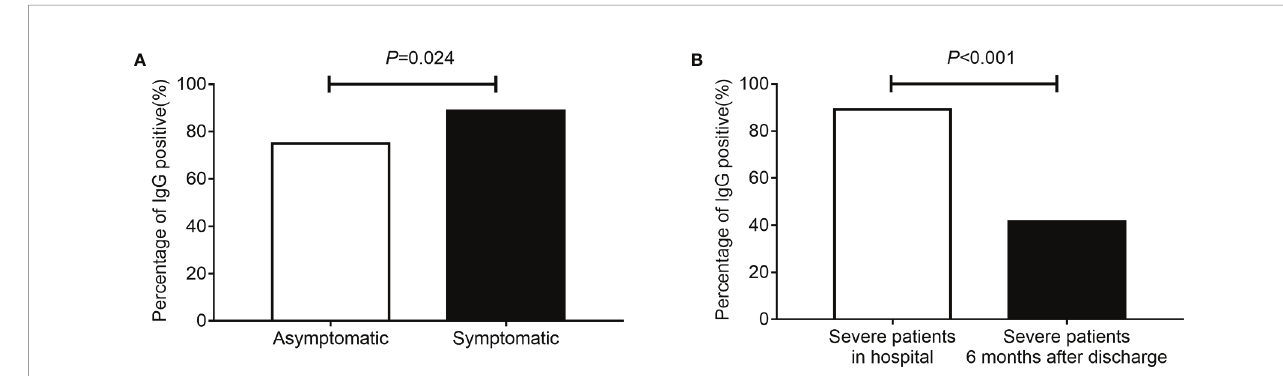
FIGURE 2 | The percentage of IgG positive. The percentage of IgG positive in asymptomatic and symptomatic patients (A) . The percentage of IgG positive in severe patients during hospital and severe patients 6 months after discharge (B)